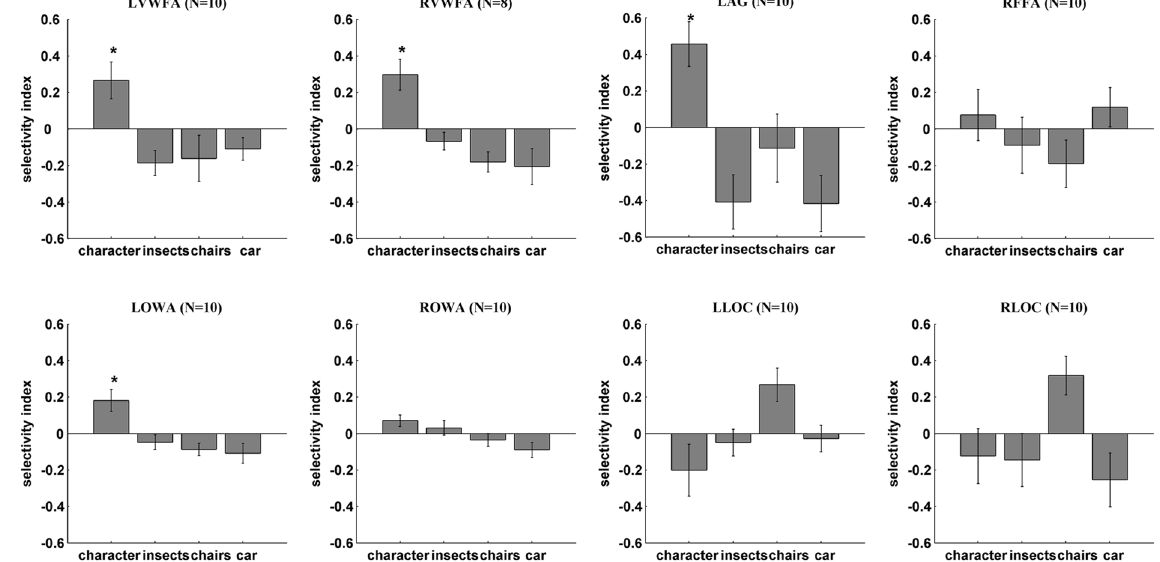
Figure 3. Selectivity index (SI) based on beta values from univariate analysis. Positive value indicates the degree of selectivity to the corresponding category relative to other categories, negative value indicates the degree of unpreference to the category relative to other categories. The LAG gains the maximum mean SI to character, followed which are LVWFA and LOWA. However, the difference of SI to character between LOWA and LVWFA or LAG are neither significant .The error bars denote the standard error calculated across subjects. The “ * ” denotes the character –SI were significantly larger than 0. (N = 10 for all the ROIs except that N = 8 for RVWFA. N: number of subjects) (the prefix “L” or “R” before each ROI name denotes left or right).